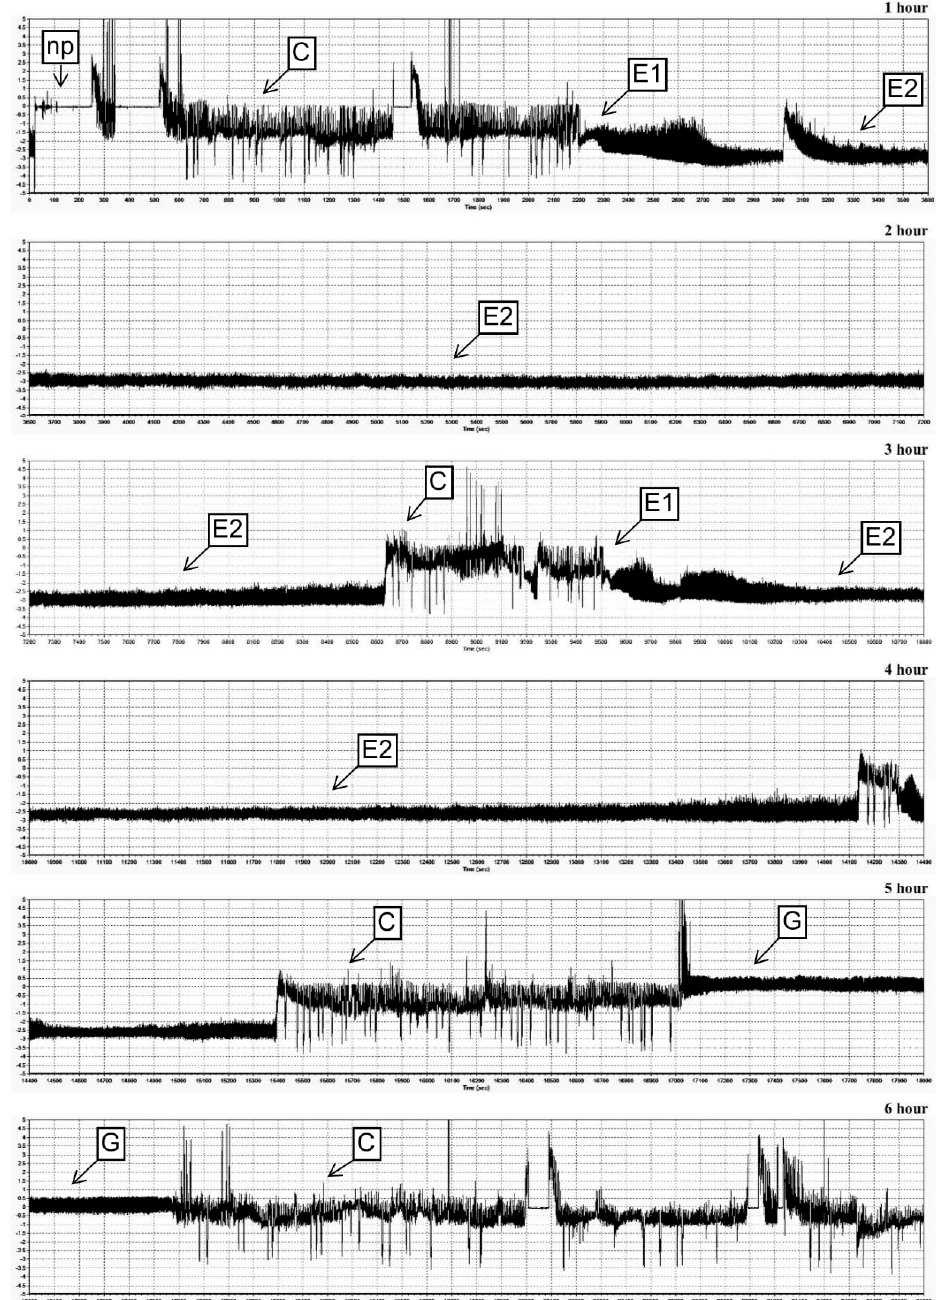
Figure 6. Electrical penetration graph recordings of stylet activities of M. dirhodum females in the maize seedling leaves of susceptible Złota Karłowa cv. Y-axis—amplitude (mV); X-axis—time (s); np—non-probing; C—transition of stylet in epidermis and mesophyll cells; E1—salivation into sieve elements; E2—phloem sap ingestion; G—xylem sap uptake.